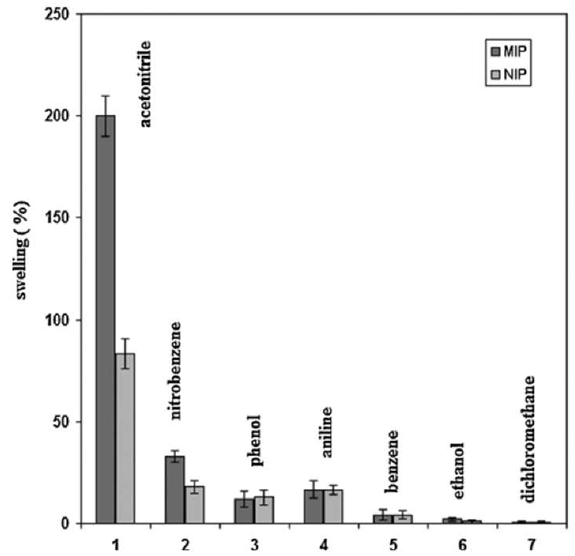
Figure 10. Swelling intensity of imprinted and non-imprinted polymers in the presence of different VOCs. MIPs are imprinted for nitrobenzene, both MIPs and NIPs are prepared using acetonitrile as porogen Reproduced with permission [203].